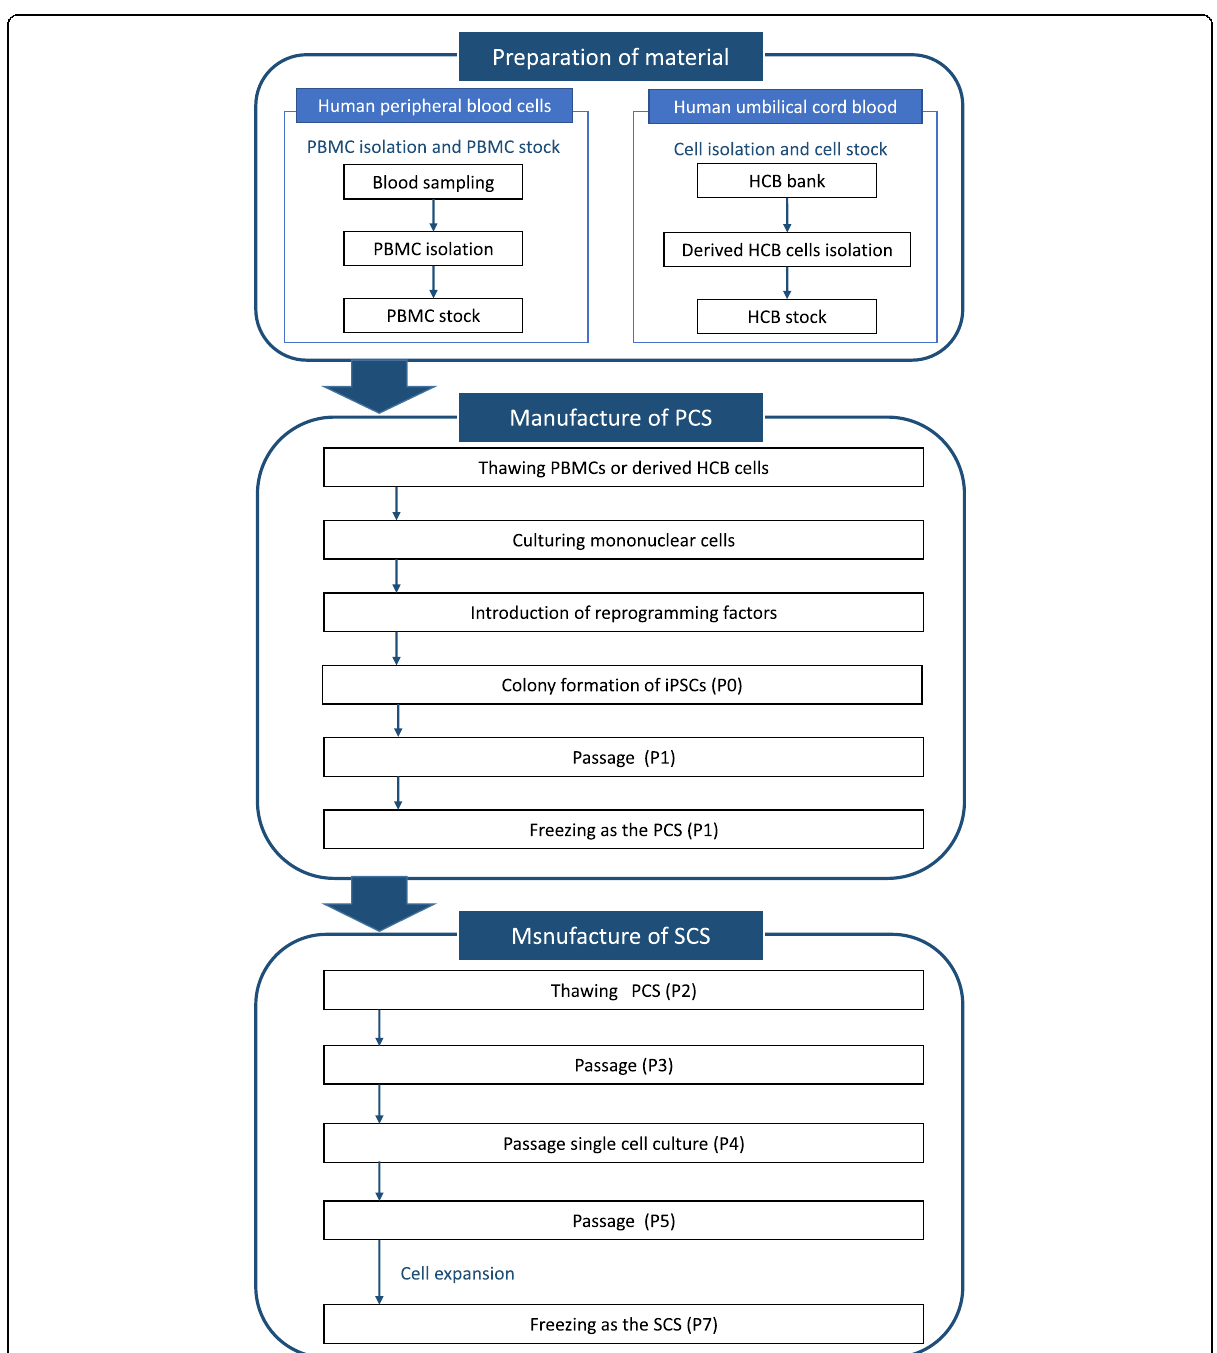
Fig. 1 Production flow of an iPS cell stock. Production is largely composed of the preparation of the materials (human peripheral blood mononuclear cells (PBMCs) and human umbilical cord blood (HCB)), the PCS and the SCS. The PCS is made from cultured cells, which are then gene-transferred to colony formation and stored at P1. For the SCS, the PCS is recultured and then frozen at